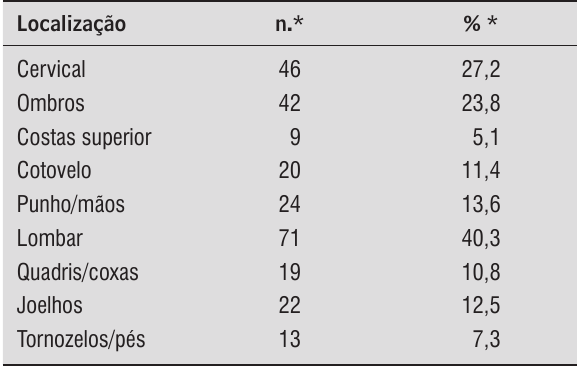
Tabela 1 - Número e proporção de sintomas